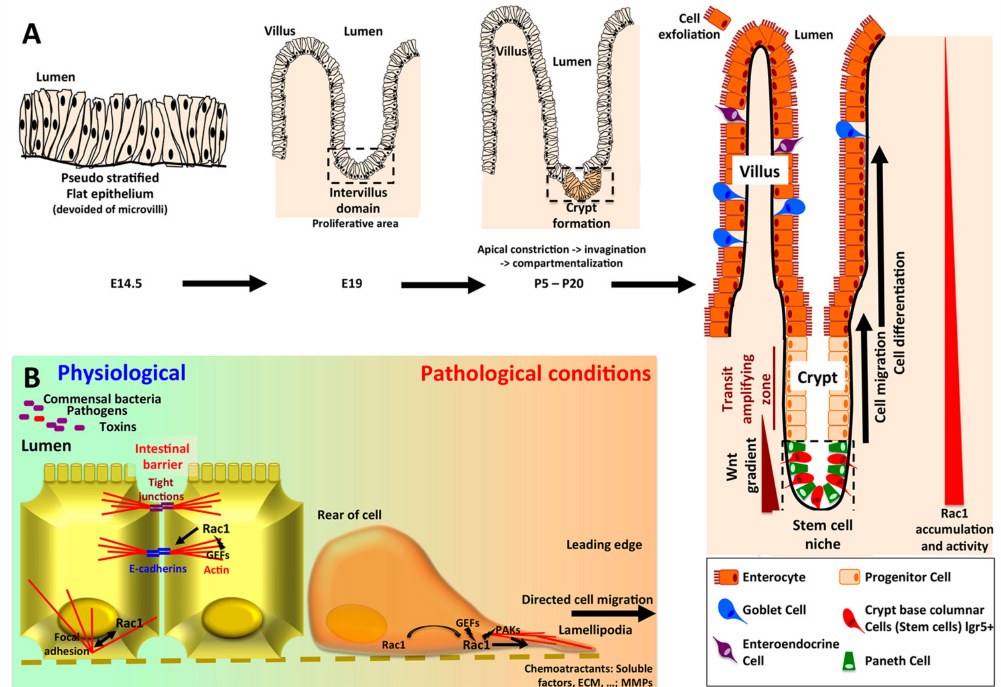
Figure 3. ( A ) Ontogeny of the crypt-villus unit. The intestinal epithelium originates from endoderm, whereas the underlying mesenchymal and muscular layers derive from mesoderm.